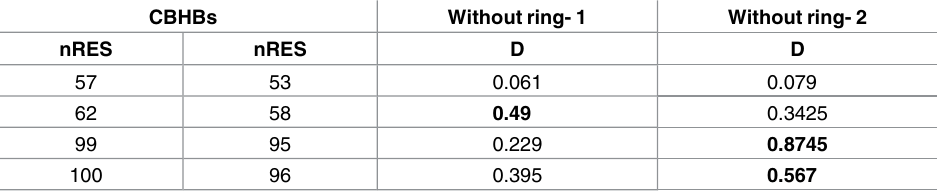
Table 3. D-values, that is, fraction of time the C-HBs of MDM2 are broken in the simulation of the complex of MDM2 with the two fragments of Nutlin-3a molecule. The four C-HBs of MDM2 are indicated by the numbers of the pair of residues involvedin the HB interaction. Each fragment of Nutlin 3a is indicated by the ring we have deleted, as illustrated in Fig 2.